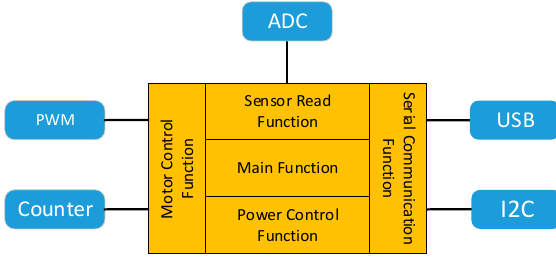
Figure 9. A brief description of the software architecture.